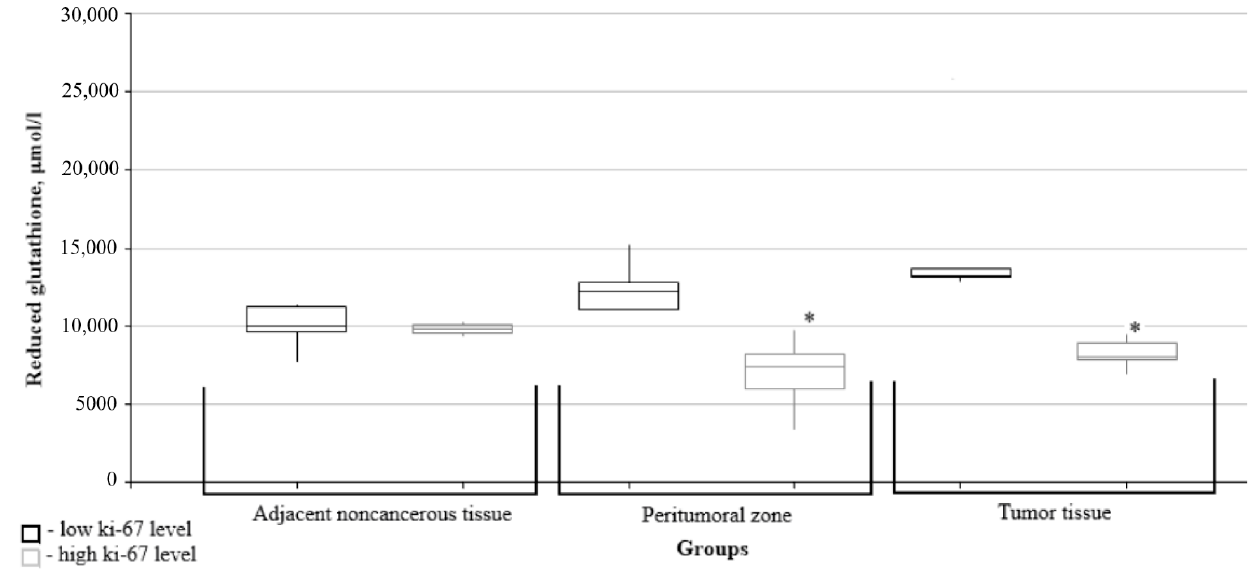
Figure 4. Medians and interquartile ranges (IQRs) of reduced glutathione level in gliomas as a function of the Ki67 mitotic index value. There are significant differences between the reduced glutathione levels in peritumoral zone tissues (*—Mann-Whitney U-test p = 0.048) and the tumors (*—Mann-Whitney U-test p = 0.004) for the low and high mitotic index Ki67 groups. The glutathione peroxidase level in the peritumoral zone was significantly lower in the high Ki-67 mitotic index group (Figure 5).